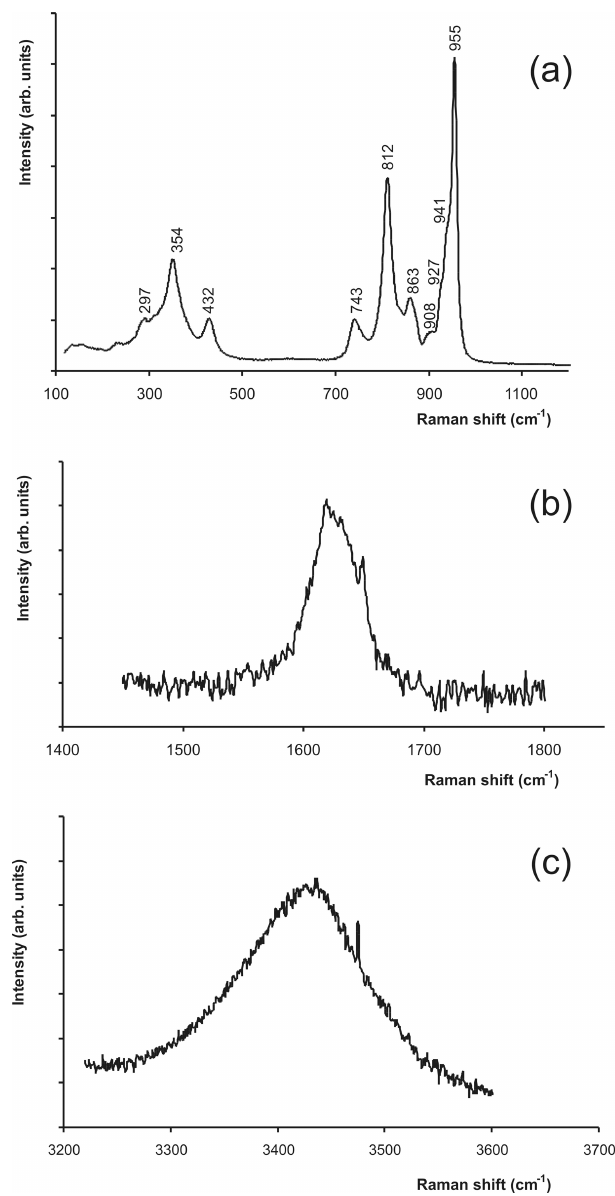
Figure 2. Micro-Raman spectra of tancaite-(Ce). The band around 1620cm − 1 (b) corresponds to the O–H bending mode, whereas the band at 3430cm − 1 (c) corresponds to the O–H stretching